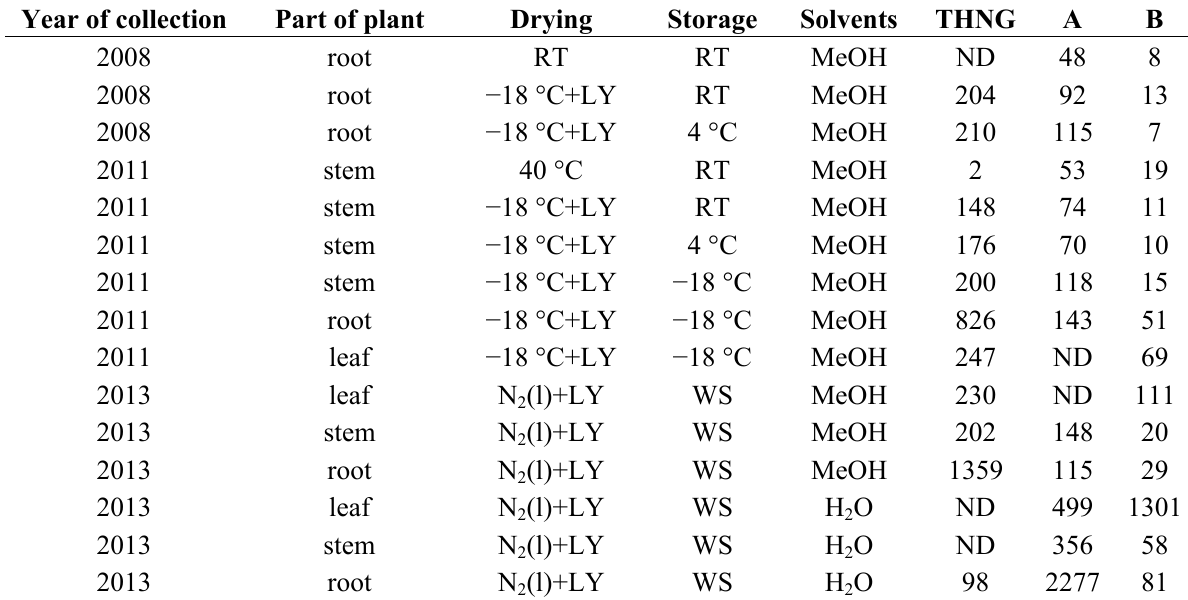
Table 1. The content of 1,2,4-trihydroxy-naphthalene-1- O -glucoside (THNG), 2-hydroxy- 1,4-naphthoquinone ( A ) and 2-methoxy-1,4-naphthoquinone ( B ) in Impatiens glandulifera Royle (mg/kg).